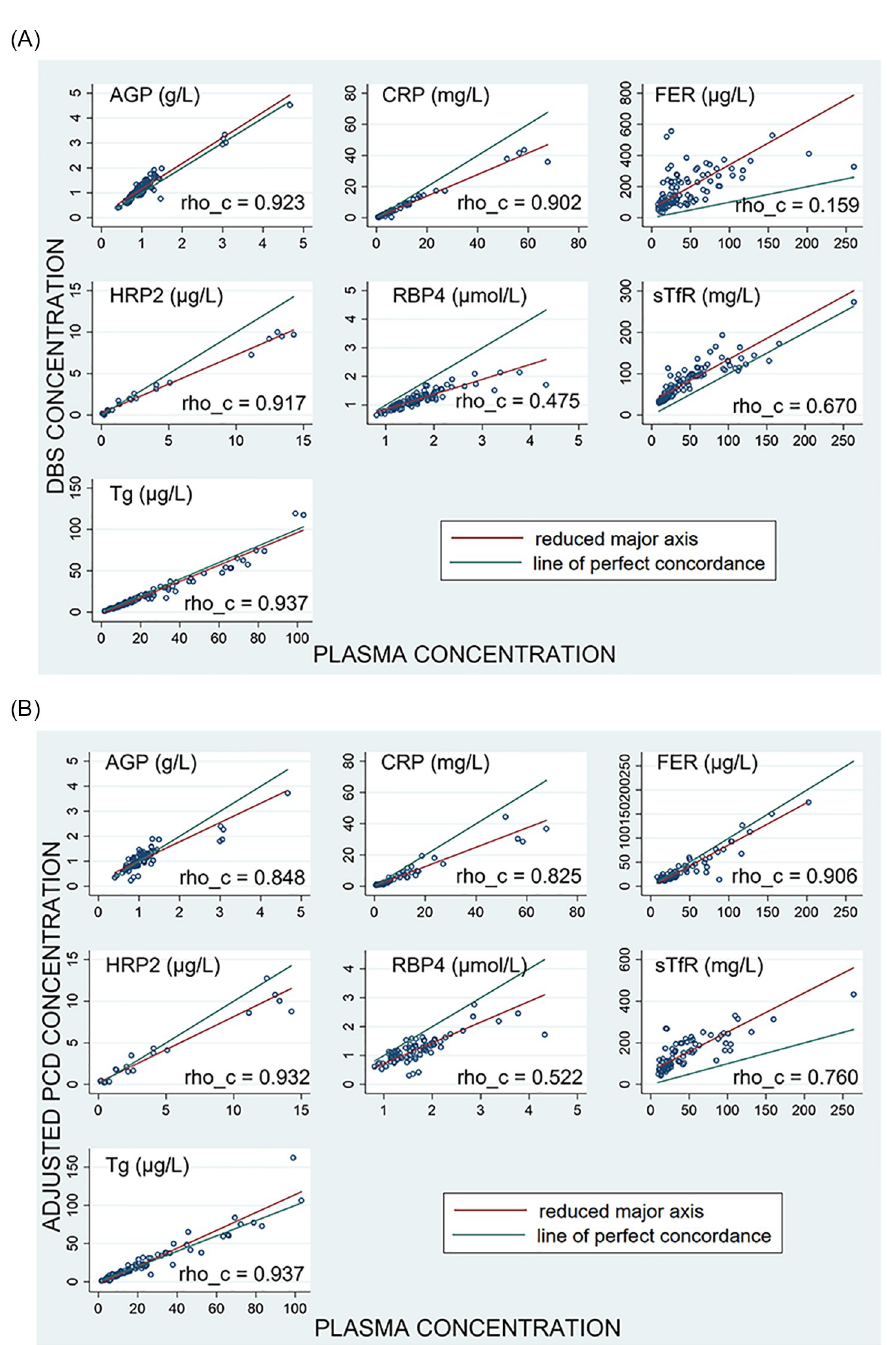
Fig 3. A . Lin’s concordance correlation coefficient (CCC) plots comparing the analyte measurements in paired wet plasma (x-axes) and DBS samples (y-axes). AGP, α -1-acid glycoprotein; CRP, C-reactive protein; FER, ferritin; HRP2, histidine rich protein 2; RBP4, retinol binding protein 4; sTfR, soluble transferrin receptor; Tg, thyroglobulin; DBS, dried blood spot; rho_c, CCC. B , Lin’s CCC plots comparing the analyte measurements in paired wet plasma (x-axes) and the adjusted PCD (y-axes). AGP, α -1-acid glycoprotein; CRP, C-reactive protein; FER, ferritin; HRP2, histidine rich protein 2; RBP4, retinol binding protein 4; sTfR, soluble transferrin receptor; Tg, thyroglobulin; DBS, dried blood spot; rho_c,